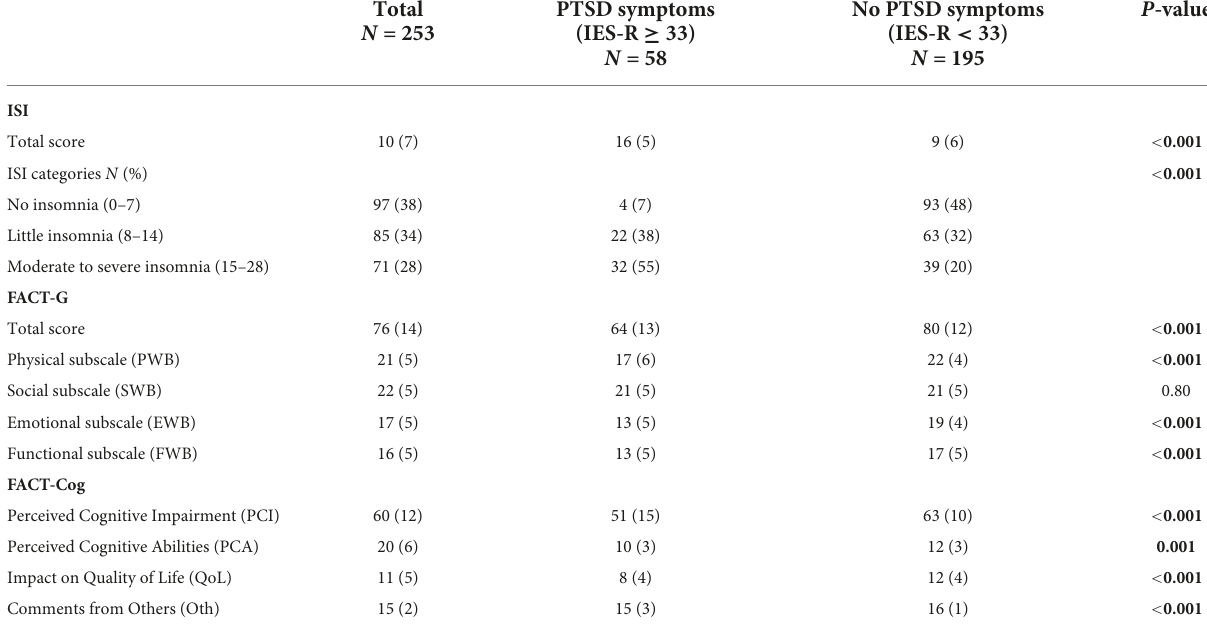
TABLE 5 Insomnia, quality of life (QoL), and cognitive complaints by post-traumatic stress disorder (PTSD) symptoms ( N = 253).